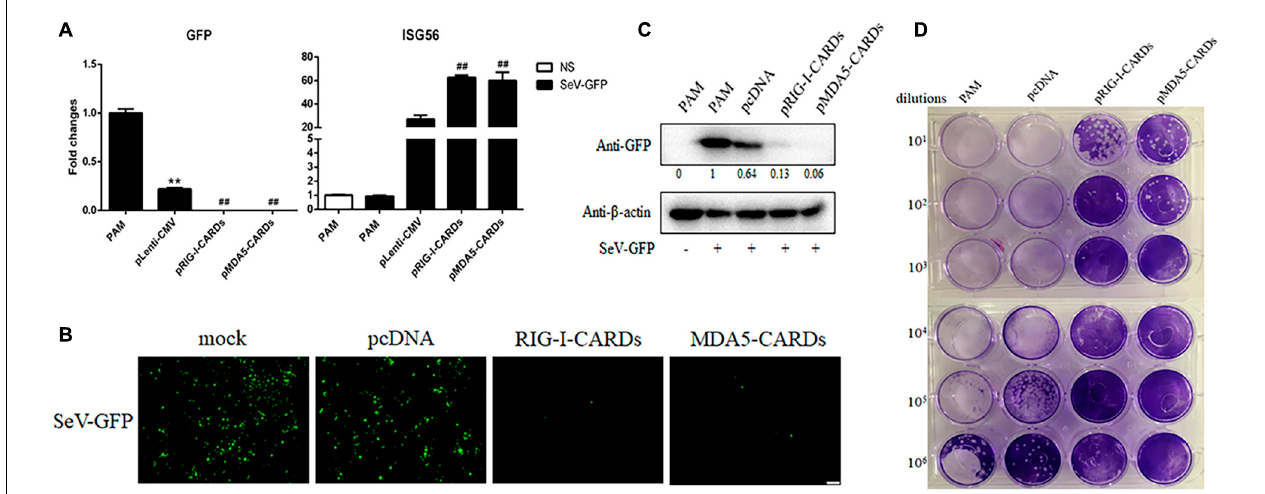
FIGURE 3 | The anti-SeV activity of porcine RIG-I and MDA5 CARDs. (A) PAMs grown on 24-well plates (3 × 10 5 cells/well) were transfected with pLenti-pRIG-I-CARDs-HA and pLenti-pMDA5-CARDs-HA and pLenti-CMV vector (0.5 µ g each) for 24 h. Then the cells were infected with SeV-GFP virus at MOI of 0.01 for 12 h and analyzed by RT-qPCR for virus replication and downstream gene expressions as indicated. (B–D) PAMs grown on 24-well plate were transfected and infected as above. The GFP signals were visualized under microscope (B) . The cells samples were detected by Western-blotting with anti-GFP mAb, with the densitometry values after actin normalization shown below the GFP blot. (C) . The supernatants from SeV infected PAMs were subjected to infection of Vero cells and the viral plaque were visualized at 24 h post infection (D) . ** p < 0.01 vs. blank controls; ## p < 0.01 vs. vector controls.